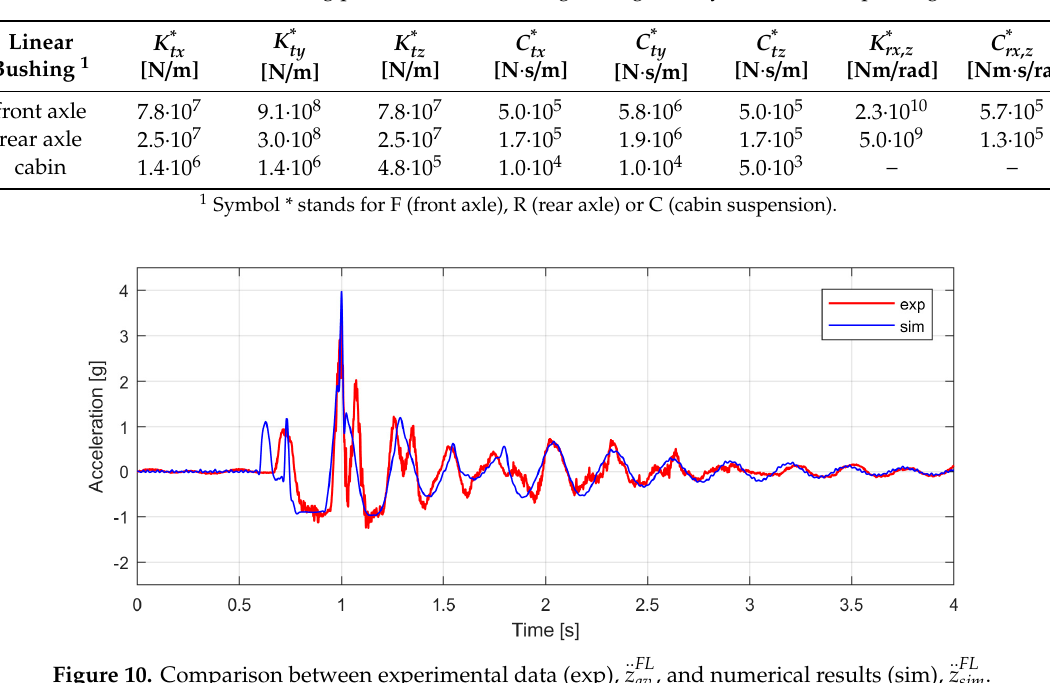
Figure 10. Comparison between experimental data (exp),